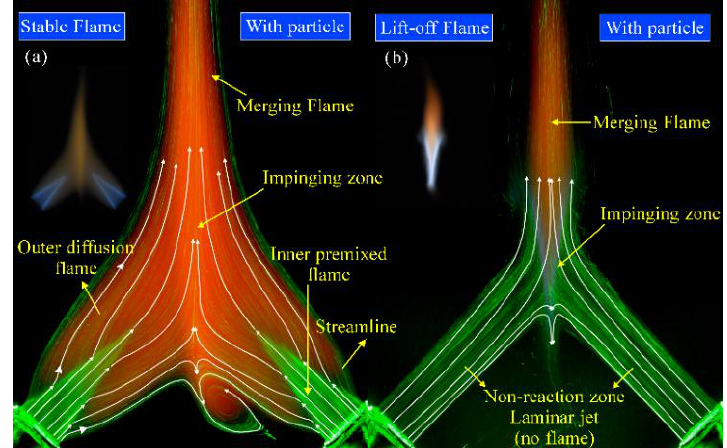
Figure 5. Direct photographs of the combination of flame pattern and the corresponding flow visualization: ( a ) stable flame; ( b ) unstable flame of a CH 4 /syngas/air premixed impinging flame.